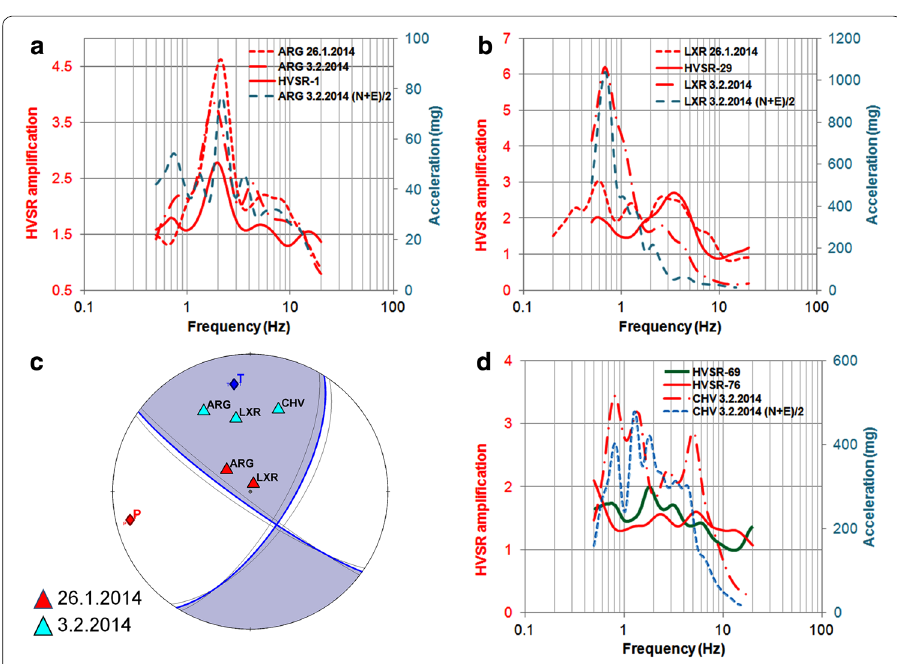
Fig. 9 HVSR curves ( red dashed lines , left vertical axis ) and average horizontal spectra ( blue dashed lines , right vertical axis ) using acceleration recordings of the two main-shocks at stations ARG ( a ), LXR ( b ), CHV ( d ) and free-field HVSR of microtremor measurements at adjacent positions ( solid lines ). The beach-ball at the ( c ) displays the average fault plane solution of the two major events and the lower-hemisphere projection of the accelerometric